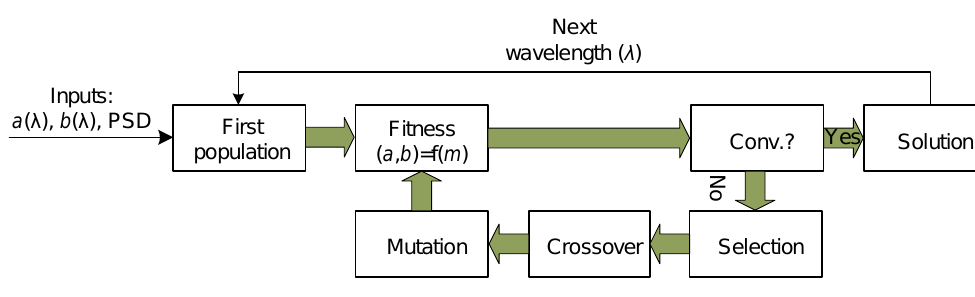
Figure 3. Flow chart for the genetic algorithm. Table 1. Summary of the refractive index retrieval